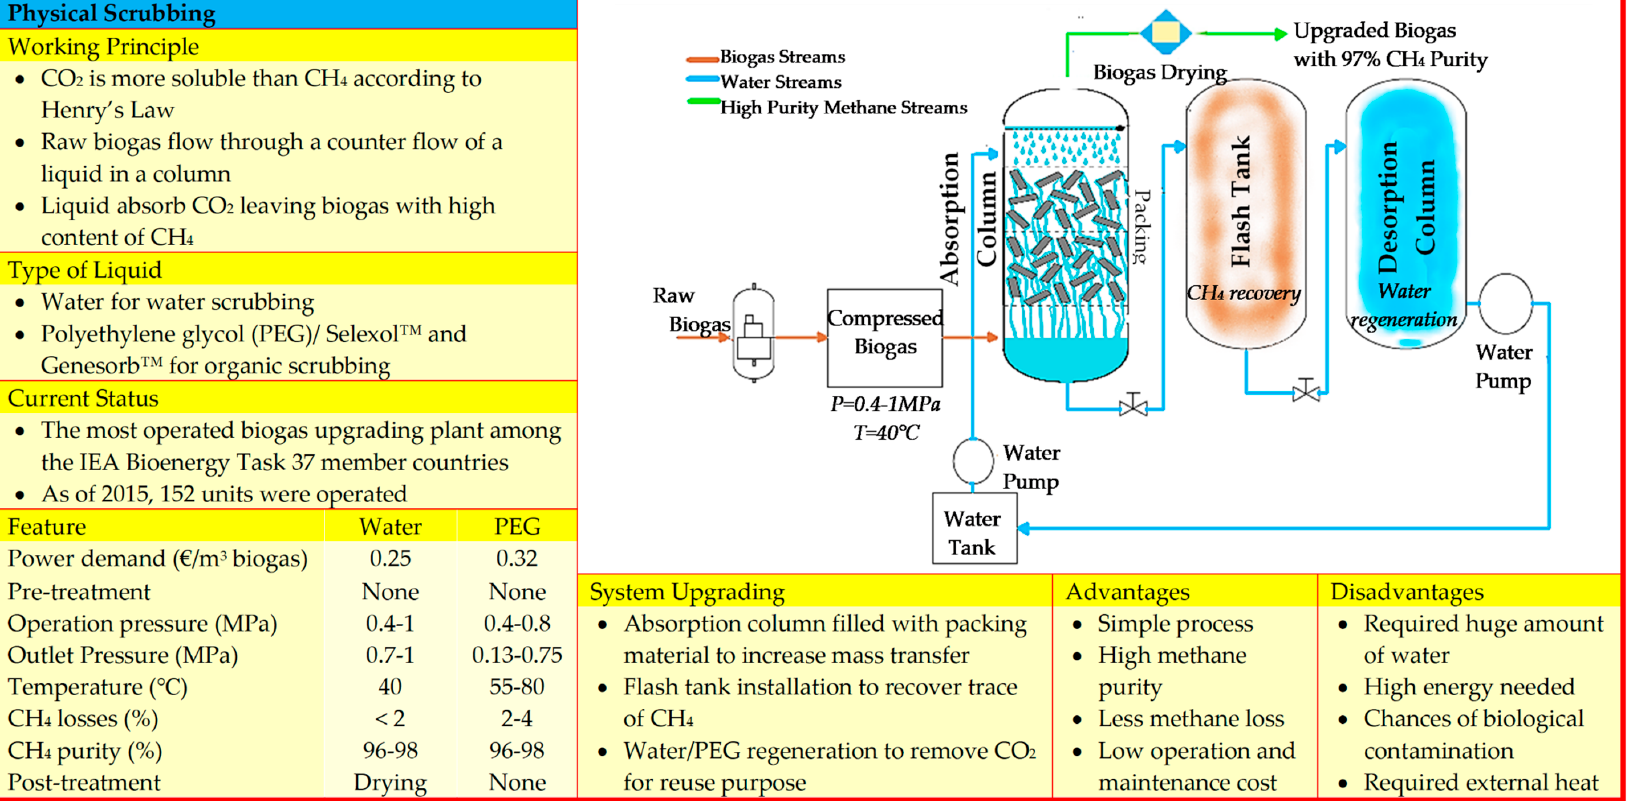
Figure 2. Summary of fundamental knowledge on physical scrubbing technology [15,19–28].